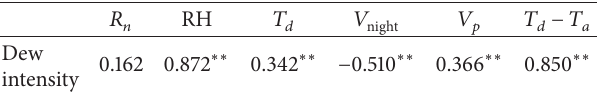
Table 1: Correlation coefficients between dew intensity and meteo- rological